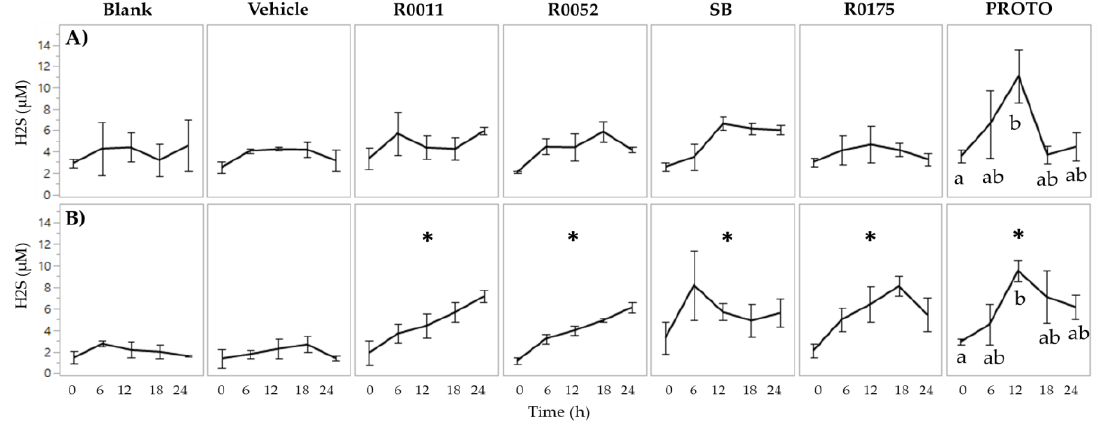
Figure 4. Determination of H 2 S in fecal water (FW); ( A ) Normal FW and ( B ) Clostridium ( C. ) difficile - infected FW. Values are shown as mean ± SEM. The symbol * represents significant differences between treatment and blank ( p < 0.05) when the means of all time points are jointly considered. R0011 = L. rhamnosus R0011; R0052 = L. helveticus R0052; SB = S. boulardii CNCM I-1079; R0175 = B. longum R0175; PROTO = ProtecFlor TM .